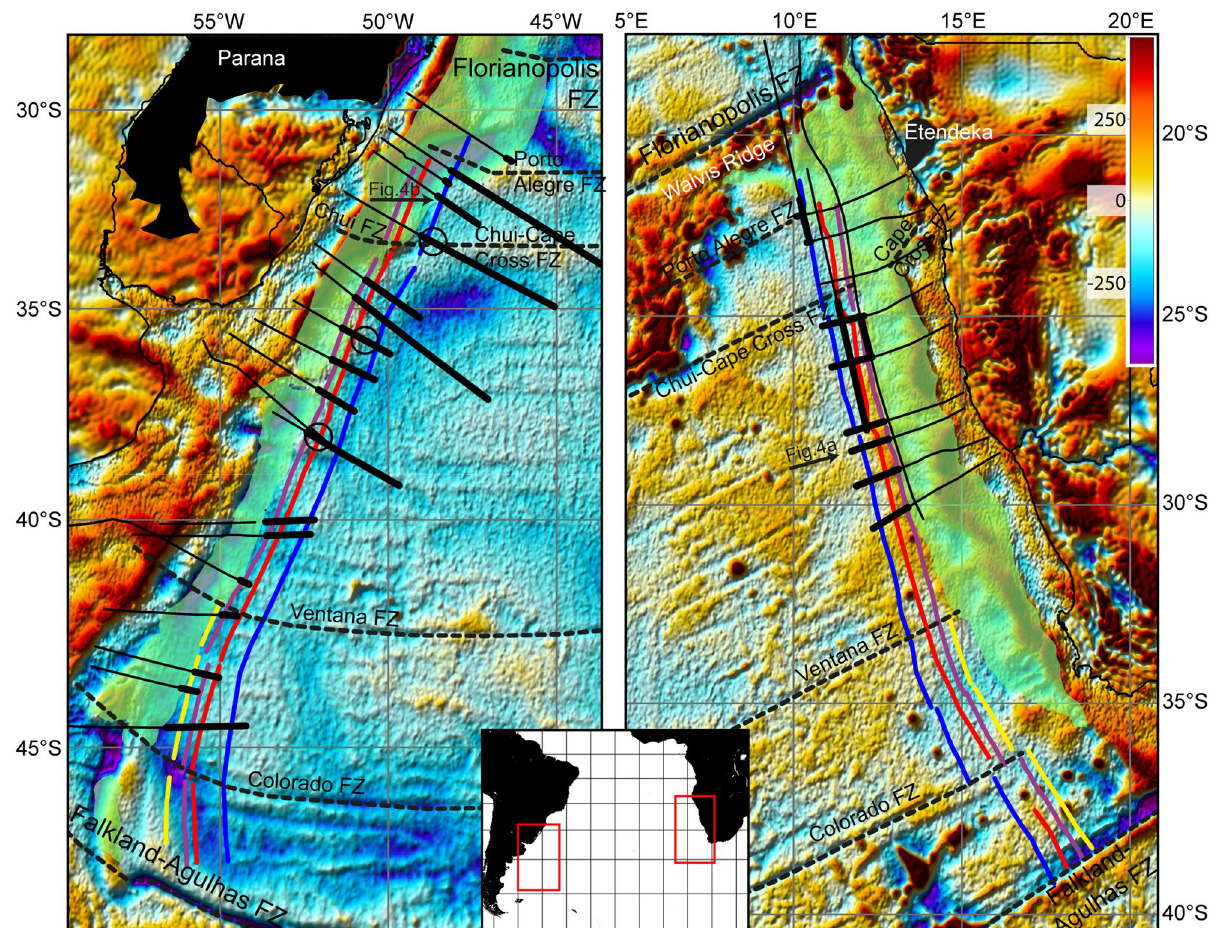
Figure 2. Maps of the conjugated South American (left) and West African (right) volcanic rifted margins. Thin black lines indicate the seismic reflection profiles used in this study (see Supplementary Figs. S1–S3). The thicker lines indicate the occurrence of oceanic crust starting from the landward limit of the oceanic crust (LaLOC) along these seismic reflection profiles. Blue, red, purple and yellow lines are M0.y, M2.o, M3.o and M4.o isochrones, respectively 30 . The black dashed lines indicate fracture zones, the black areas show the Paranà- Etendka igneous province and the green areas show the SDRs extent 39 . The free air gravity anomaly grid (mGal) deduced from satellite altimetry data 58 is shown in background. Empty circles indicate the location of the three seismic profiles, within the oceanic domain, shown in Fig.